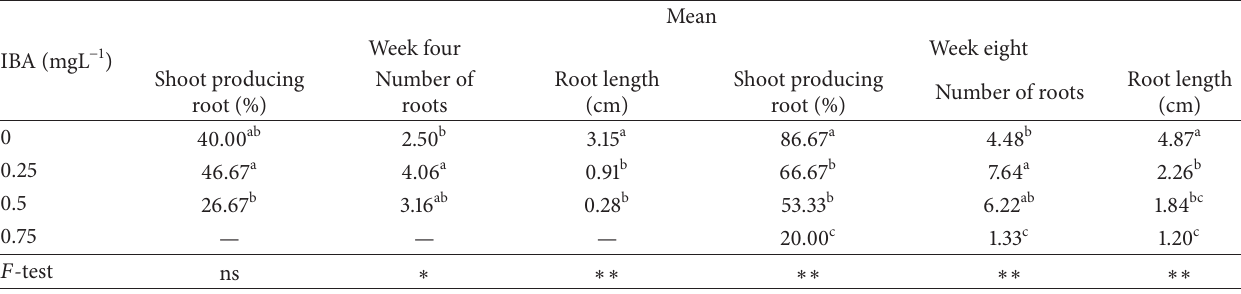
Table 3: Effect of different concentration of IBA on percentage of shoots producing root, number of roots, and root length after four and eight weeks of transferring onto rooting